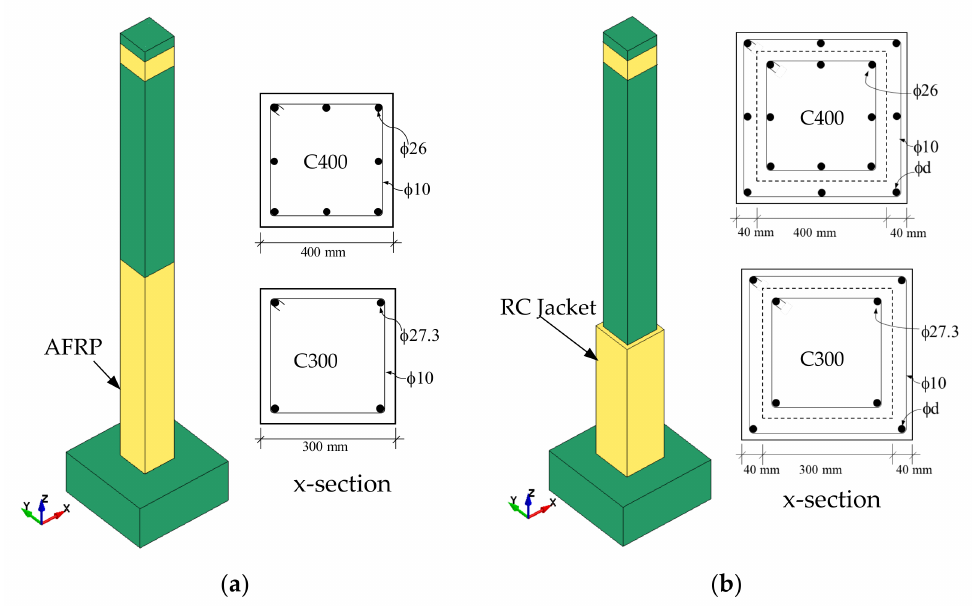
Figure 17. Column protection by: ( a ) AFRP sheet; ( b ) RC